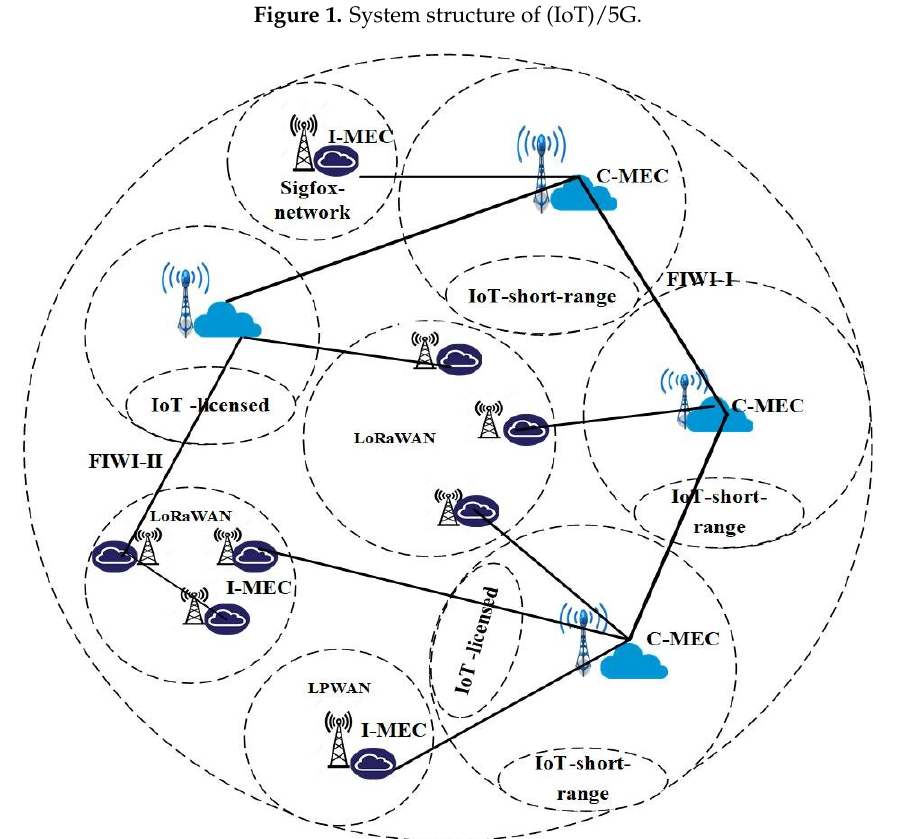
Figure 2. Heterogeneous IoT networks connected to 5G edge servers.